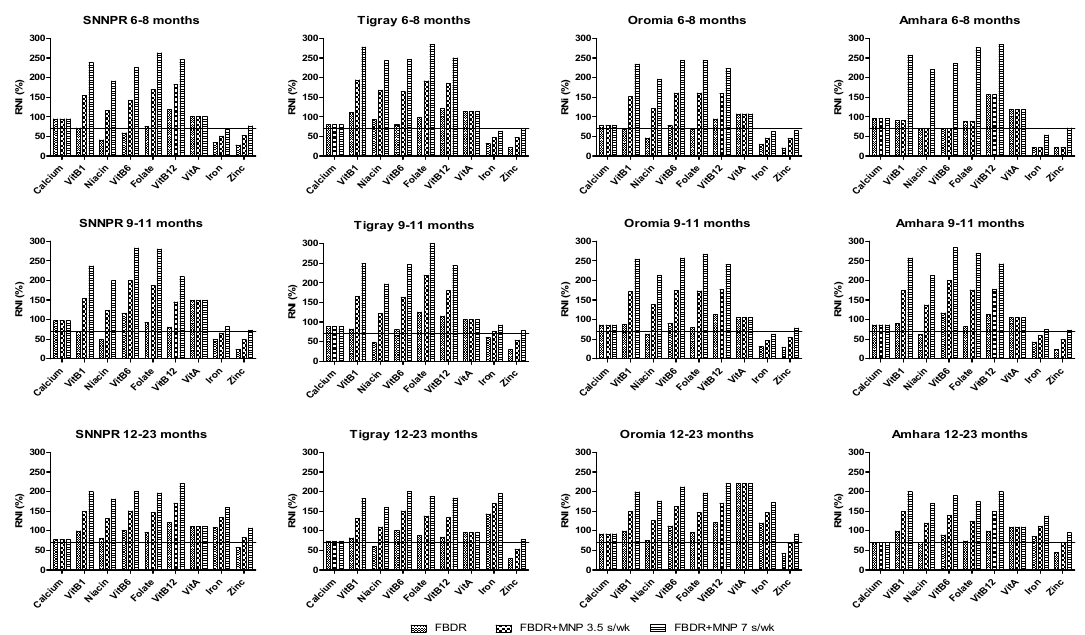
Figure 1. Minimized nutrient values (Module III) of different diet scenarios compared with Recommended Nutrient Intake (RNI) for 6–23 months in regions of Tigray, Amhara, Oromia and South Nations, Nationalities and Peoples Region (SNNPR). Table 5. Calculated inadequate and excess intake of selected nutrients at usual intake, addition of 1 MNP every other day (3.5 sachets/week) and daily, among Ethiopian children at different age groups. Nutrient *(EAR)